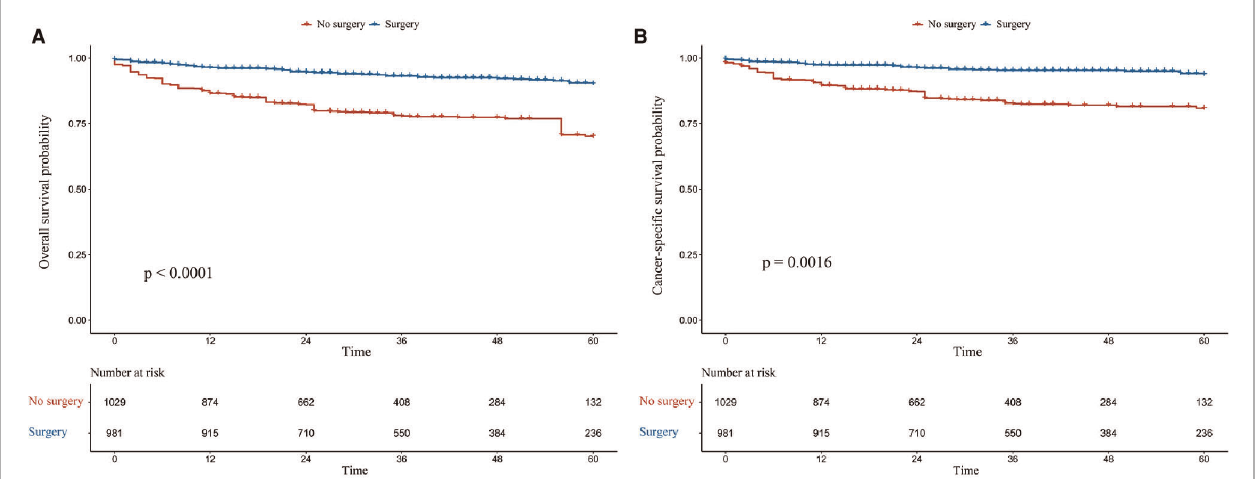
FIGURE 2 | Kaplan – Meier survival estimates of overall ( A ) and cancer-speci fi c ( B ) survival in the overall population after inverse probability of treatment weighting adjustment.